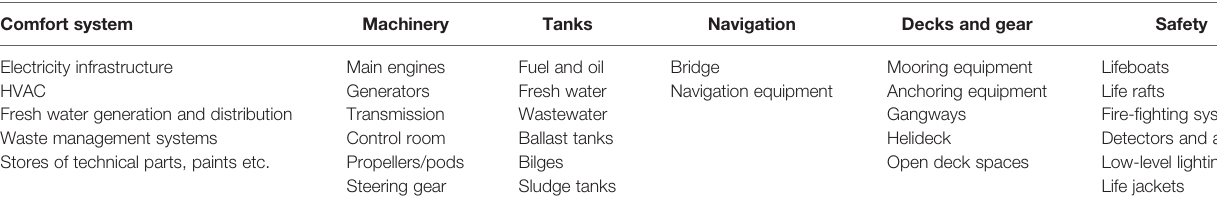
TABLE 4 | Ship facilities on board cruise ships [adapted from Lois et al. (2004)]. Comfort system